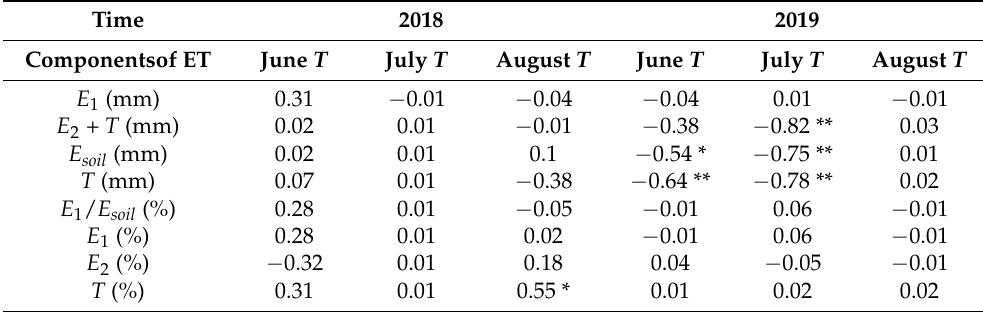
Table 2. Correlation between temperature and evapotranspiration flux